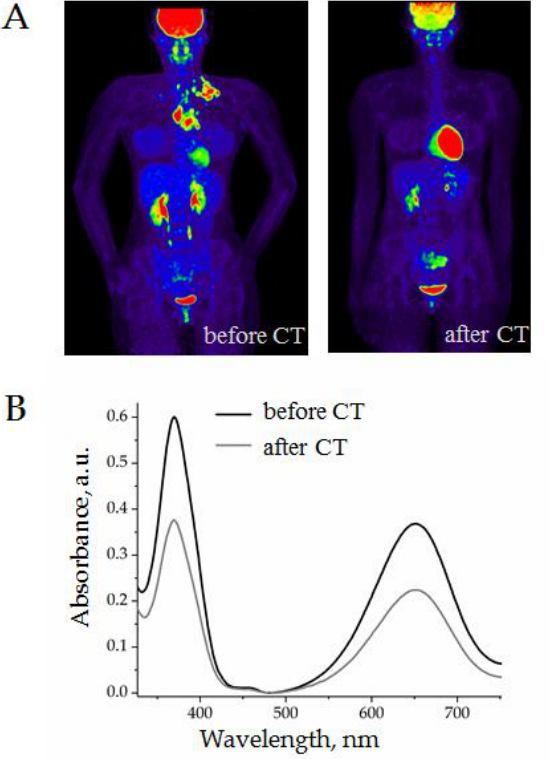
Figure 10. Evaluation of the results of two cycles of chemotherapy (ABVD) of a 36-year-old female patient: ( A ) PET-CT images before and after treatment; ( B ) quantification of CD30 + SEVs in plasma by the AuNP aptasensor before and after treatment.